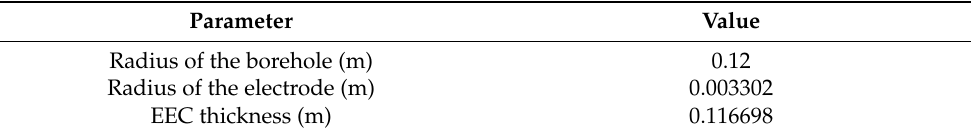
Table 4. Details about the EEC required for modelling in CDEGS.